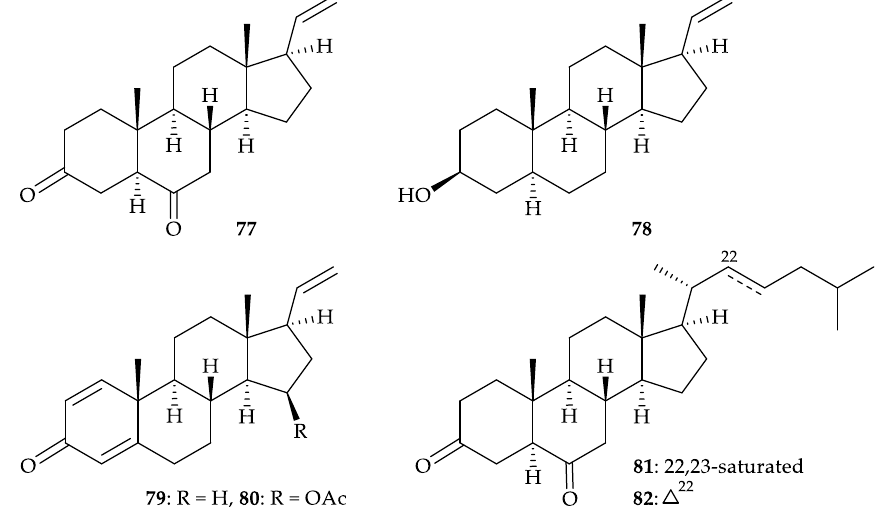
Figure 12. Structures of 5α-pregn-20-en-3,6-dione ( 77 ), 5α-pregn-20-en-3β-ol ( 78 ), 1,4,20-pregna- trien-3-one ( 79 ), 15β-acetoxypregna-1,4,20-trien-3-one ( 80 ), 5α-cholestan-3,6-dione ( 81 ), and 5α- cholest-22-en-3,6-dione ( 82 ).